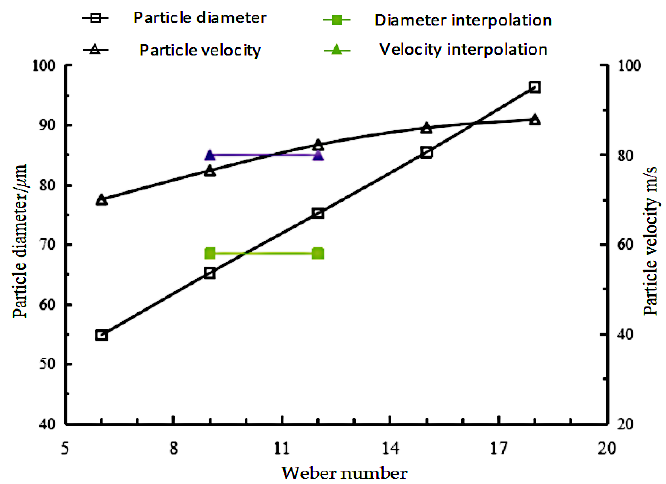
Figure 15. Experimental interpolation to find the critical Weber Number.